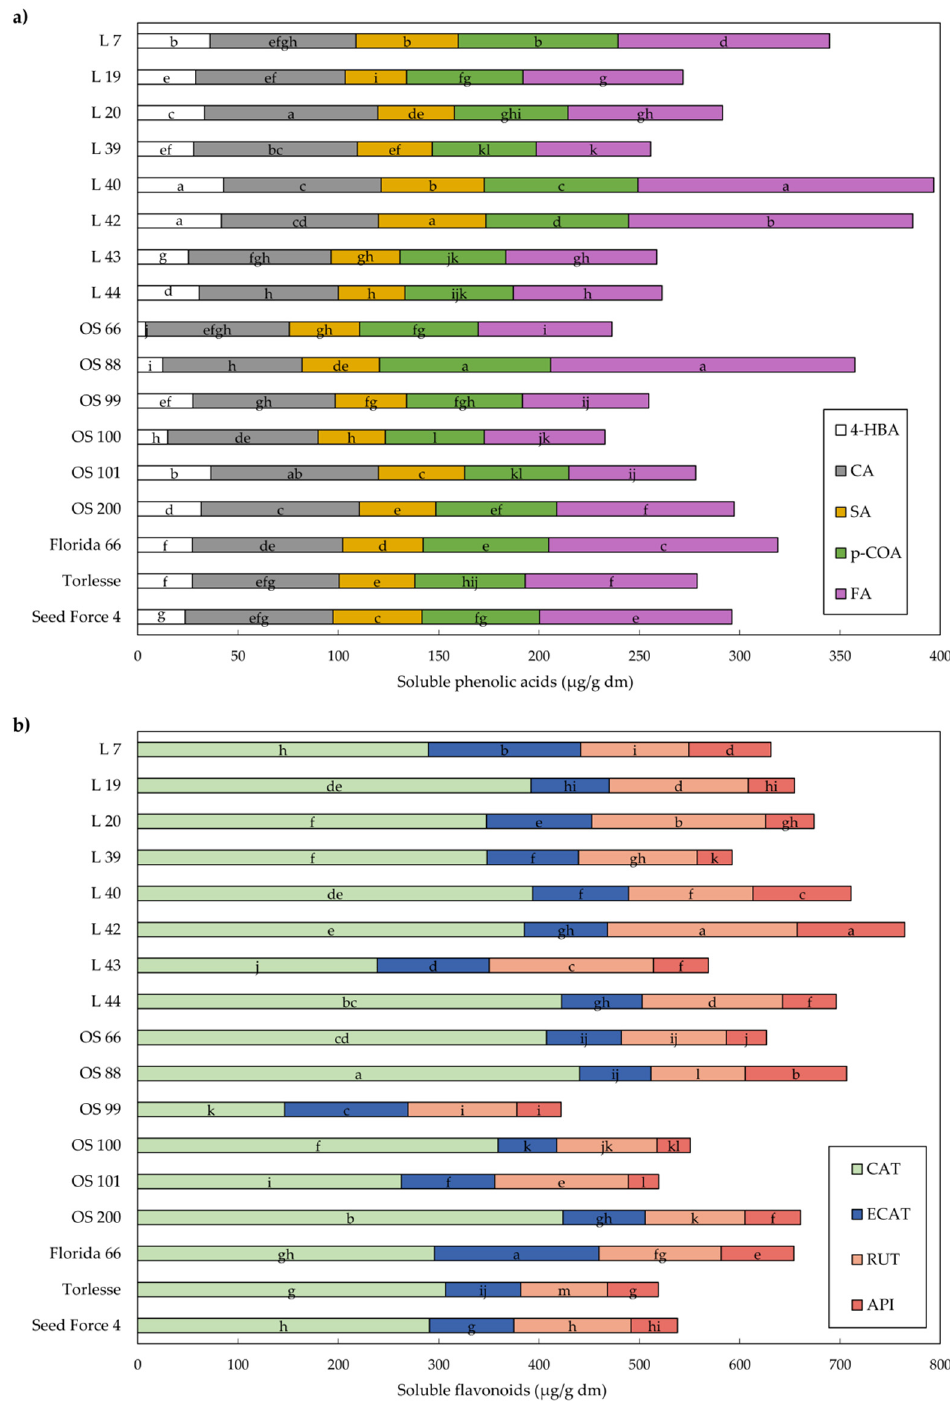
Figure 2. Mean values of soluble phenolic acids ( a ) and flavonoids ( b ) in alfalfa. Different letters indicate significant difference among accessions at p < 0.05 according to the LSD test. 4-HBA—4-hydroxybenzoic; CAT—catechin; CA—caffeic acid; SA—syringic acid; ECAT—epicatechin; p-COA—p-coumaric acid; FA—ferulic acid; RUT—rutin; API—apigenin.